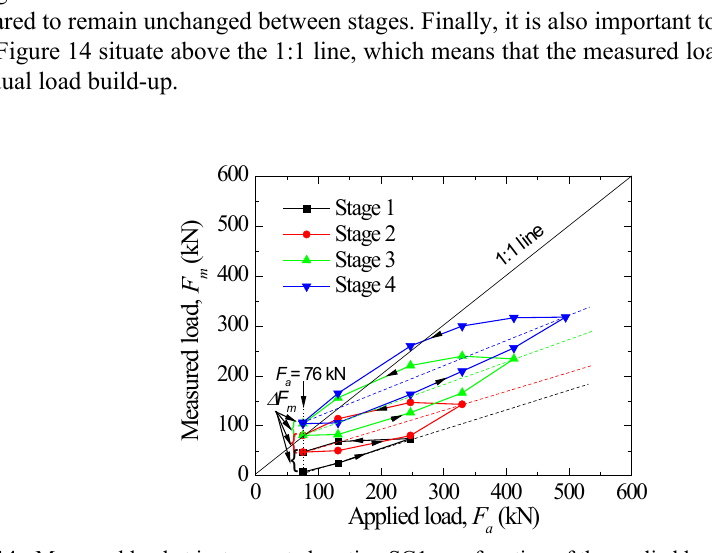
Figure 14 - Measured load at instrumented section SG1 as a function of the applied load at the anchor